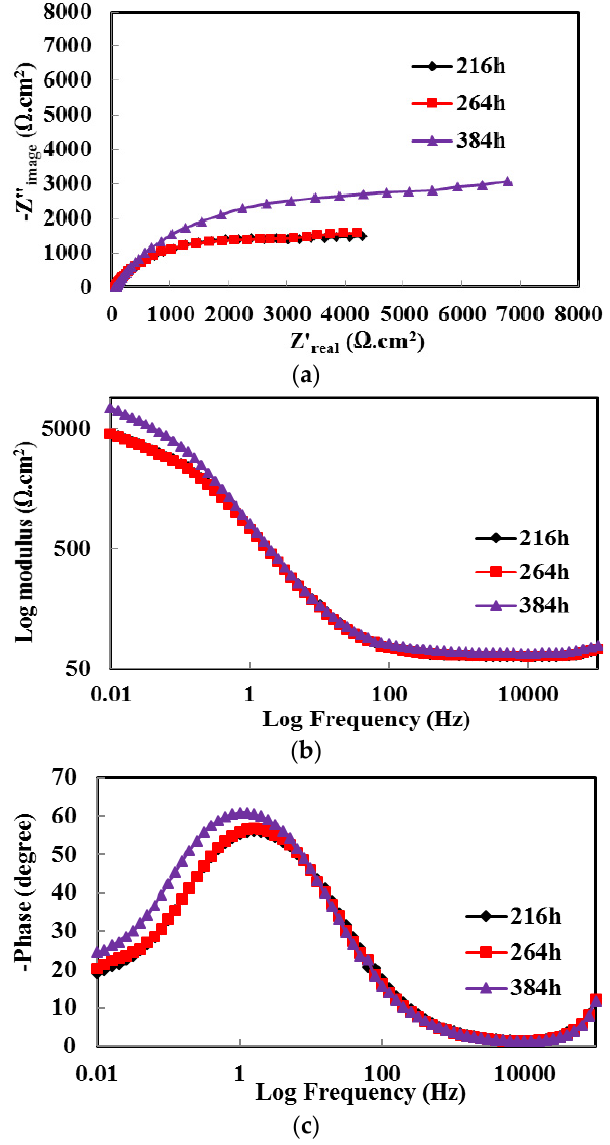
Figure 8. Electrochemical impedance studies of Al coating in SAE J2334 solution with exposure periods ( a ) Nyquist, ( b ) Bode impedance ‐ frequency, ( c ) Bode phase ‐ frequency plots.